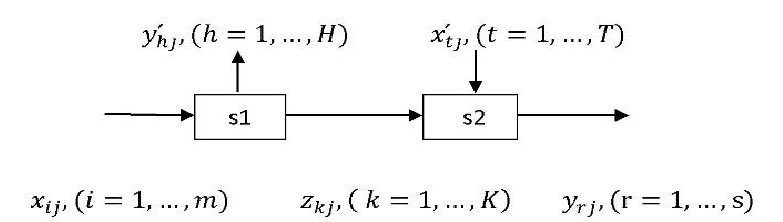
Fig. 2. General two-stage network